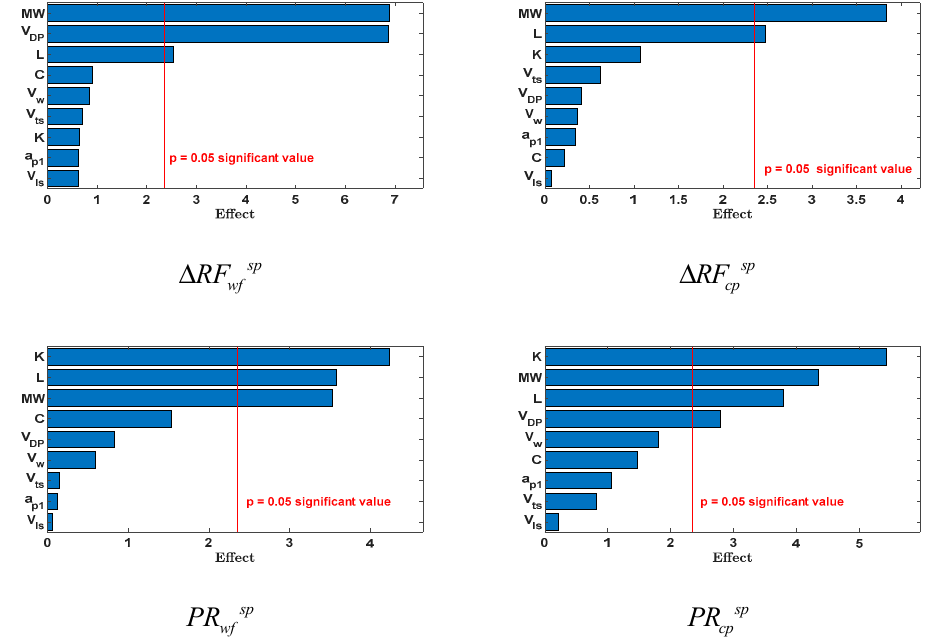
Figure 10. Pareto chart for the selected objective functions using a folded two-level Plackett–Burman design as part of the parameter screening workflow. Parameters with an effect less than the red line are considered insignificant, and more than the red line are considered heavy-hitters.